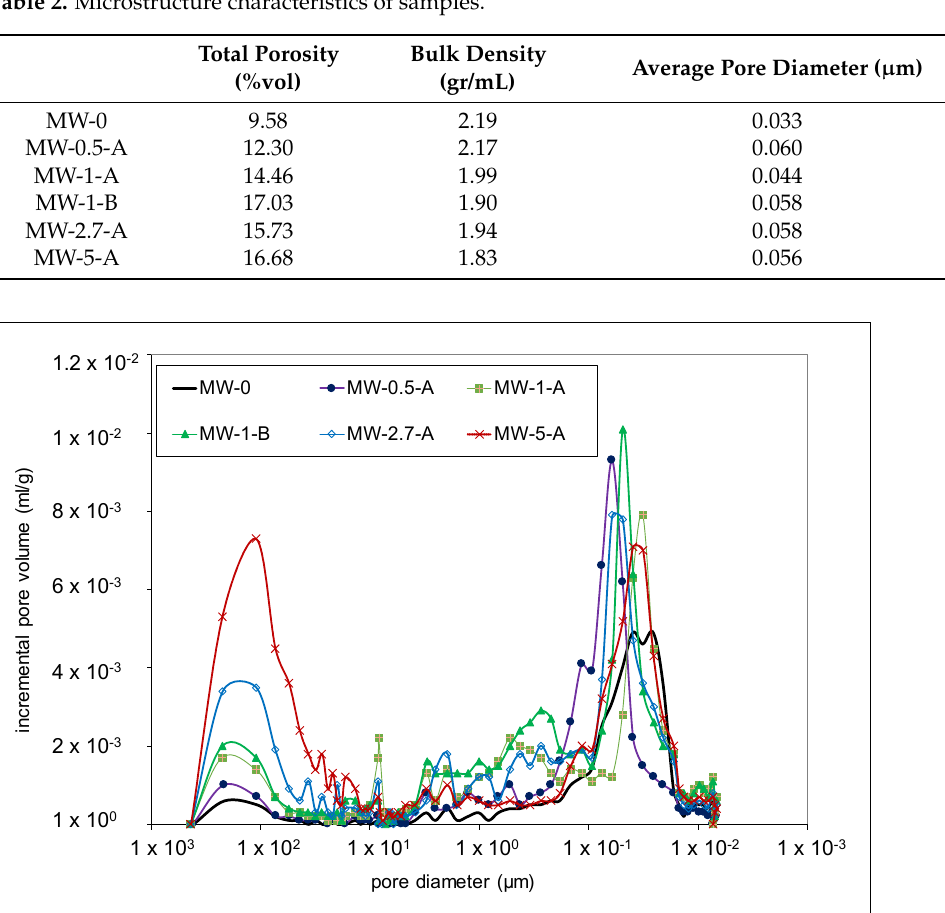
Table 2. Microstructure characteristics of samples.